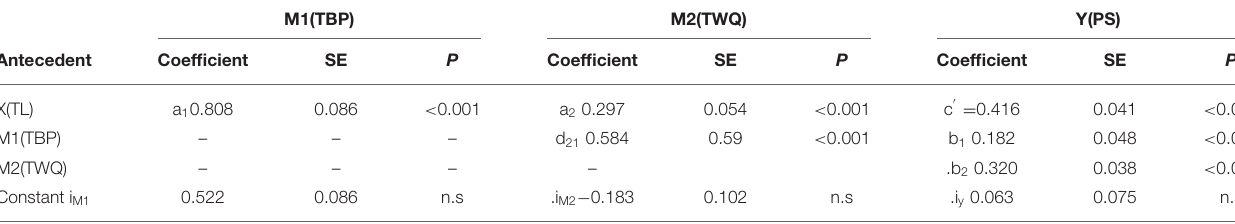
TABLE 4 | Regression coefficients and model summary information for the serial multiple mediator model.